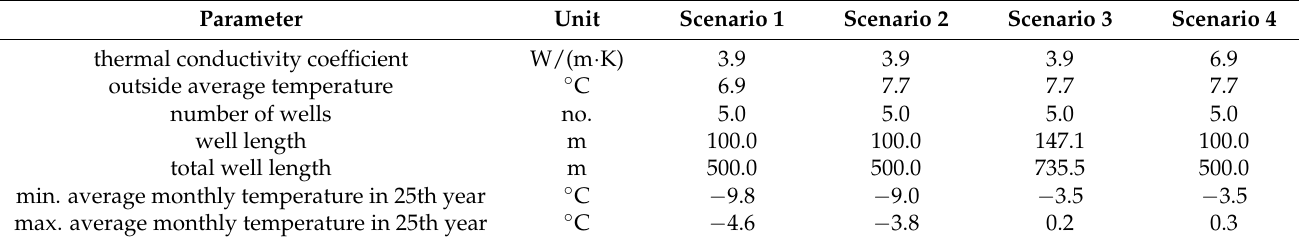
Table 2. Overview of parameters for each